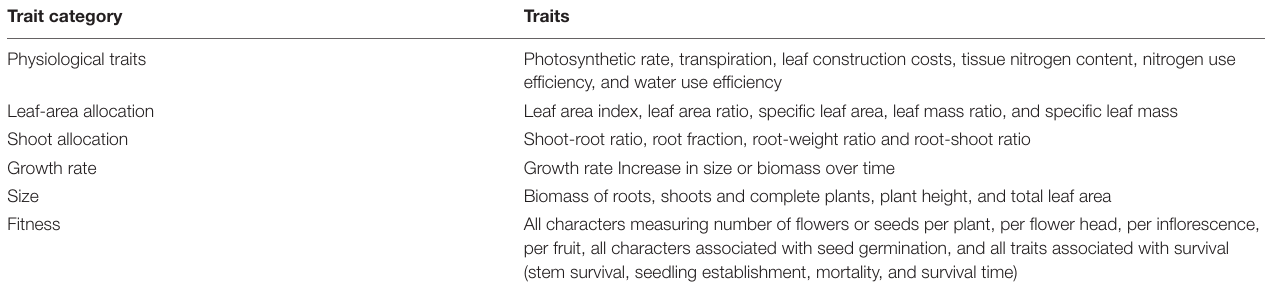
TABLE 1 | Six functional trait that are known to reflect the common characteristics of invasive exotic plant species (van Kleunen et al., 2010). Trait category